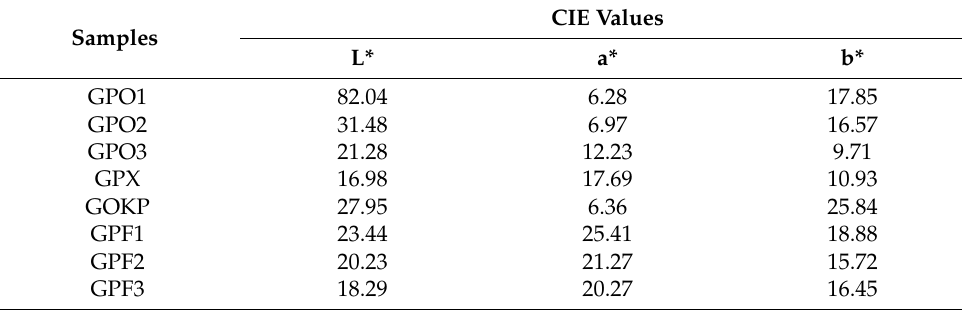
Table 3. CIE L*a*b* coordinates of glazes.